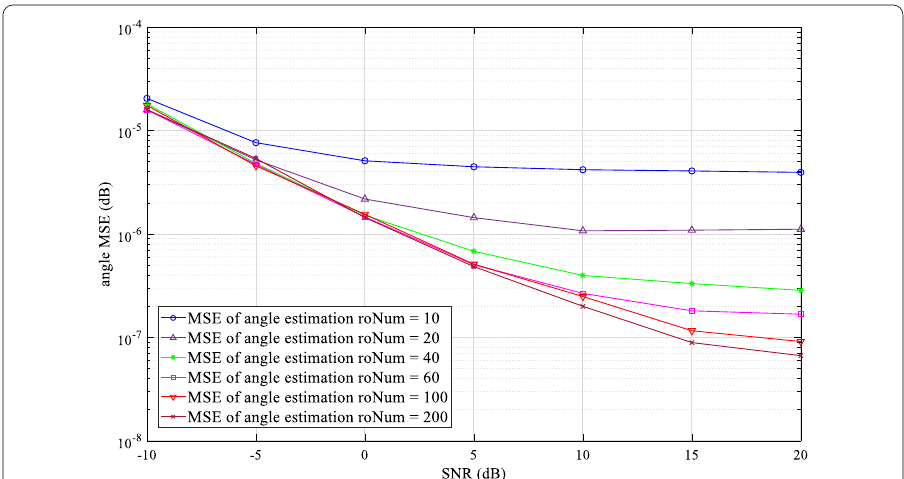
Fig. 7 Comparison of MSE of the proposed angle estimation with different the number of searches. Illustrates the variation of angle MSE as SNR for the proposed method with different search times of angle rotation